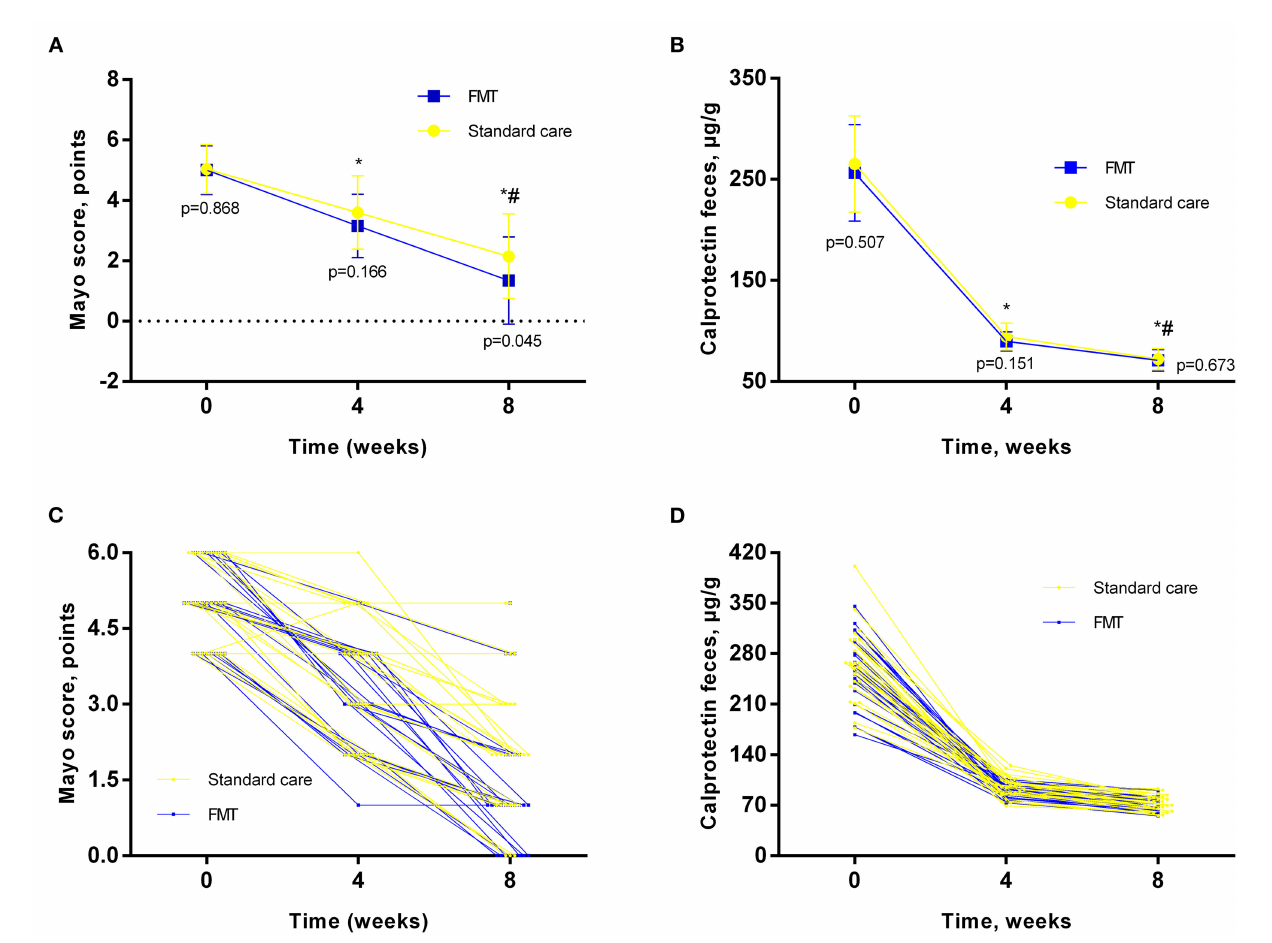
FIGURE2 Main outcomes analysis in different timepoints. (A, C) –Mayo Score; (B, D) –fecal calprotectin; Data expressed as mean ± SD (A, B) and individual values (C, D) . RM-ANOVA was used to identify any differences within groups. p – indicates the difference between groups at the same timepoint. * - as compared to baseline; # - compared to 4